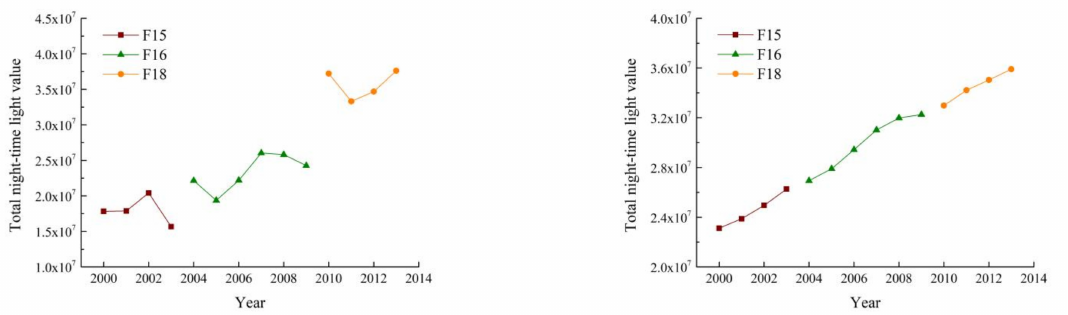
Figure 3. Total nighttime light value (TNLV) of noncorrected DMSP nighttime light data across China ( left ) and that of corrected DMSP nighttime light data ( right